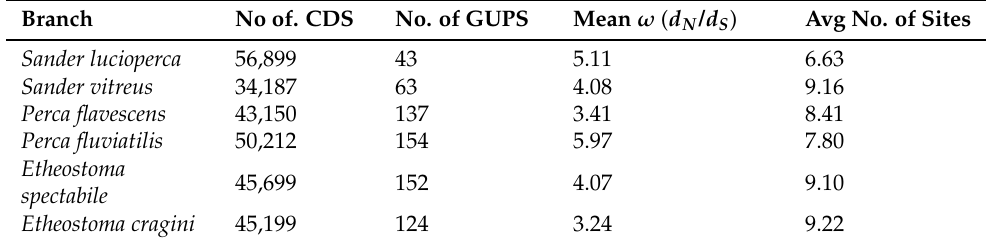
Table 5. Statistics on lineage-specific positive selection in the six representative Percidae species.